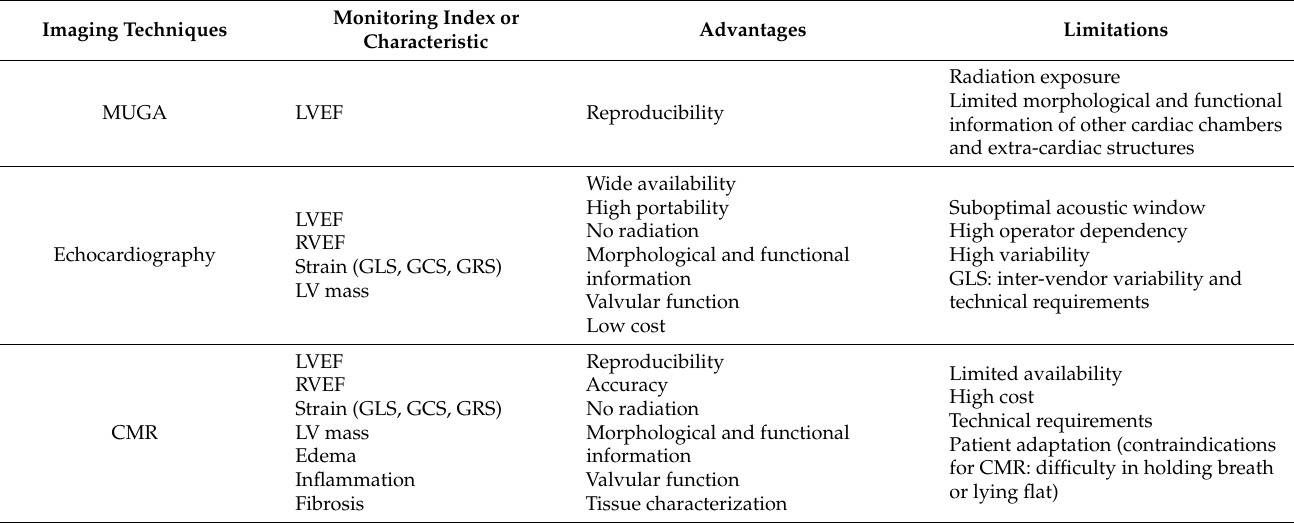
Table 2. Advantages and limitations of different imaging techniques in the diagnosis of